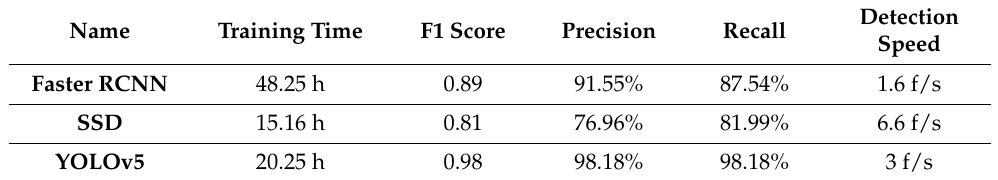
Table 3. Testing Results for testing data set two.